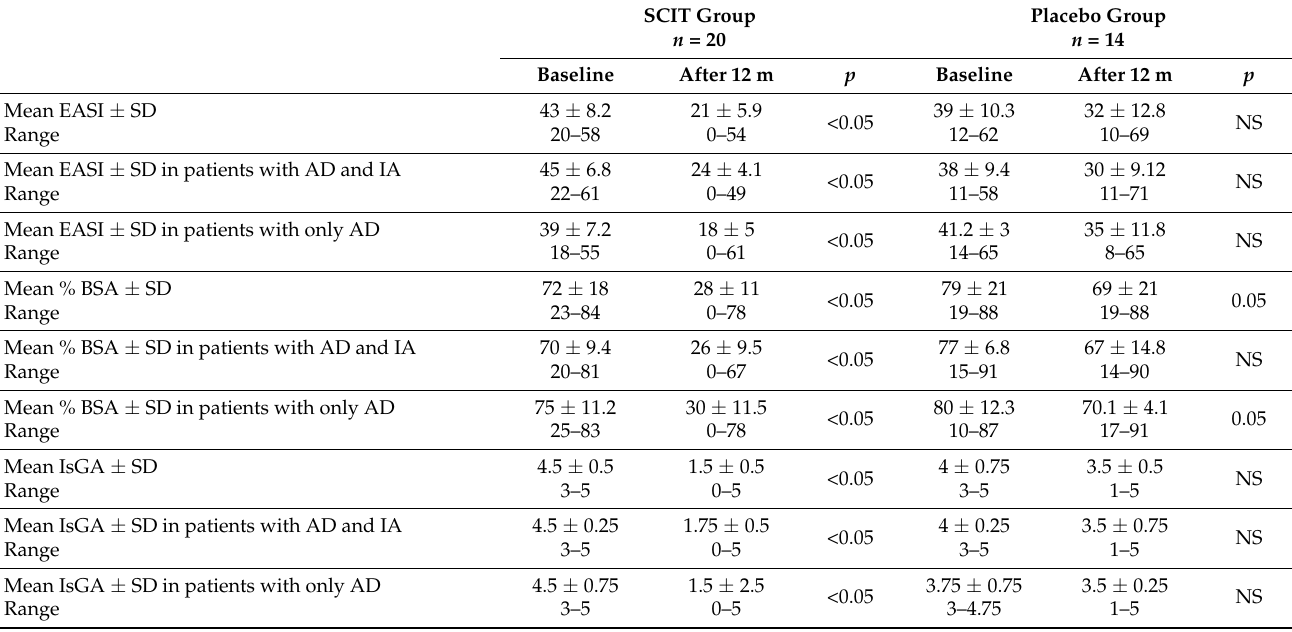
Table 2. The mean changes in EASI, % BSA, and IsGA in the studied patients during the 12 months of